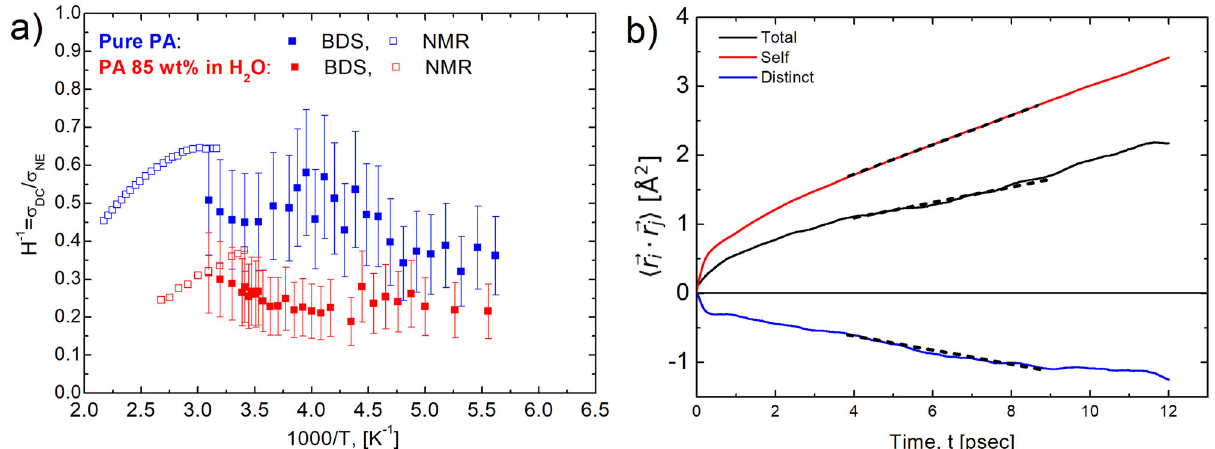
Fig. 10 Inverse Haven ratio and correlation functions of proton displacement vectors. a Temperature dependence of the inverse Haven ratio for PA (blue symbols) and PA85 (red symbols) estimated using diffusion coef fi cients obtained from NMR 20,21 (open squares) and BDS (closed squares). Error bars are standard deviation. b Correlation functions of proton displacement vectors for pure PA at 400 K and the linear fi t to obtain self-, distinct, and total diffusion coef fi cients using